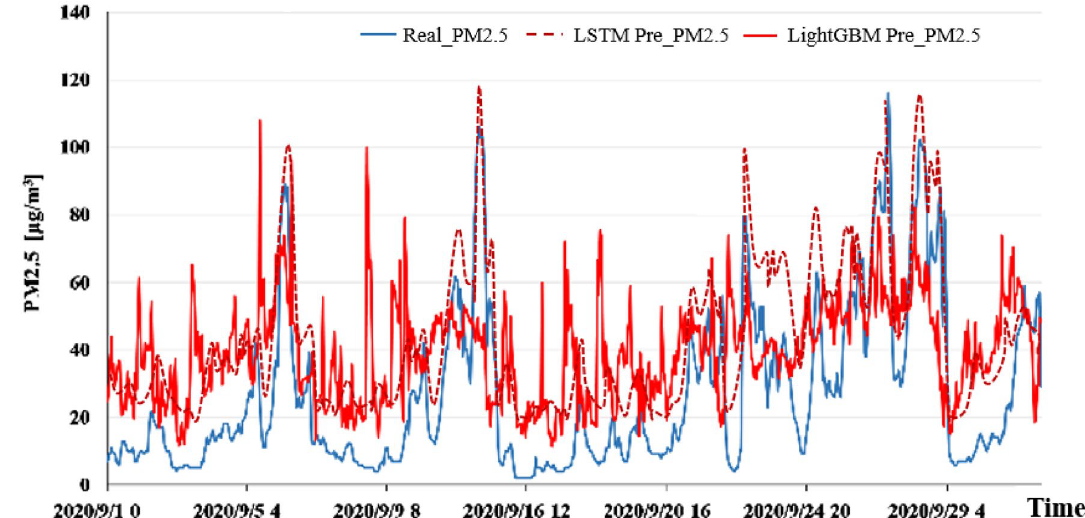
Figure 10. Comparison of prediction results between LightGBM and LSTM models at Dongsi air quality